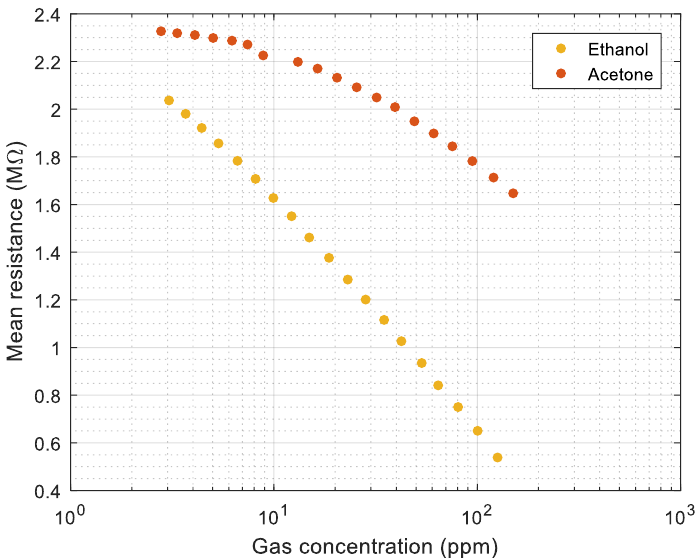
Figure 6. Representation of the volatile calibration results: mean resistance of the sensing layer of the 16 MOX gas sensors relative to the concentration of ethanol and acetone measured with the